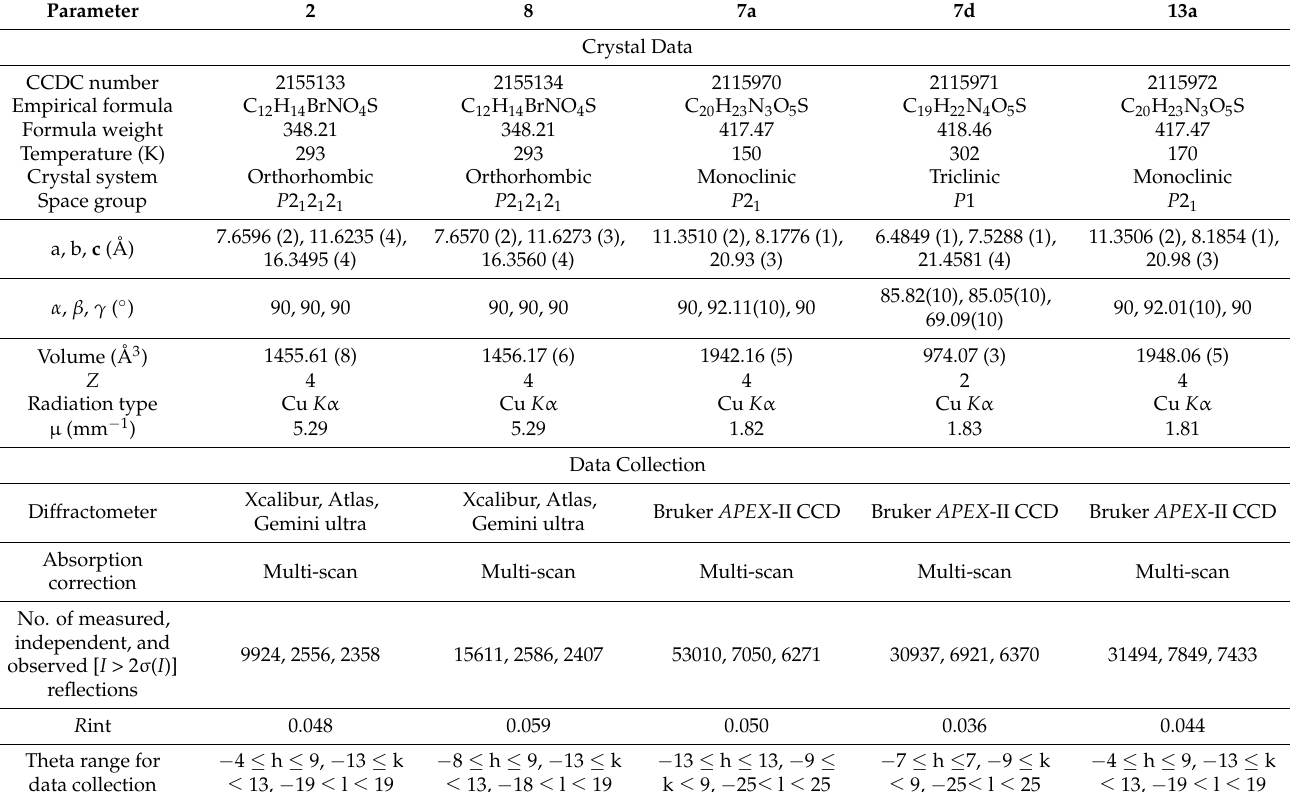
Table 4. Crystallographic data and structure refinement parameters of compounds 2 , 8 , 7a , 7d , and 13a